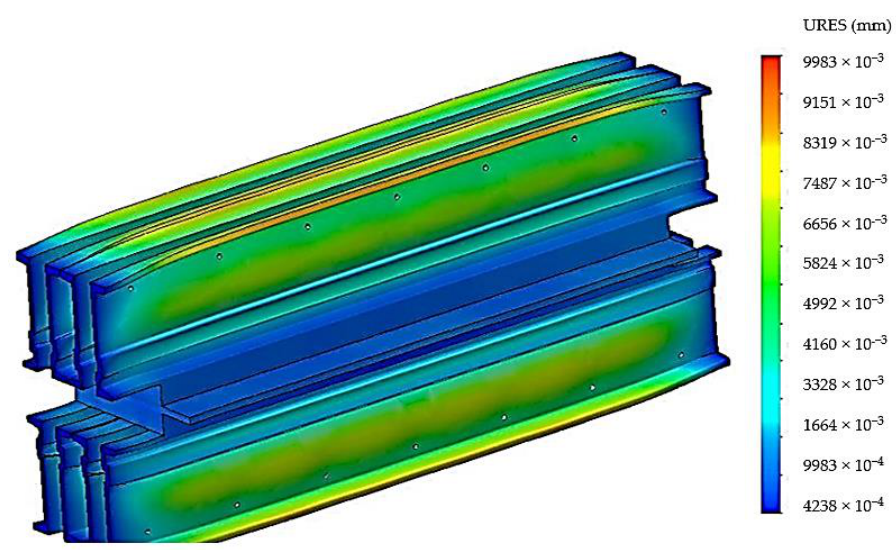
Figure 12. Deformation in the modified belt vulcanization press when seven spacers are used.